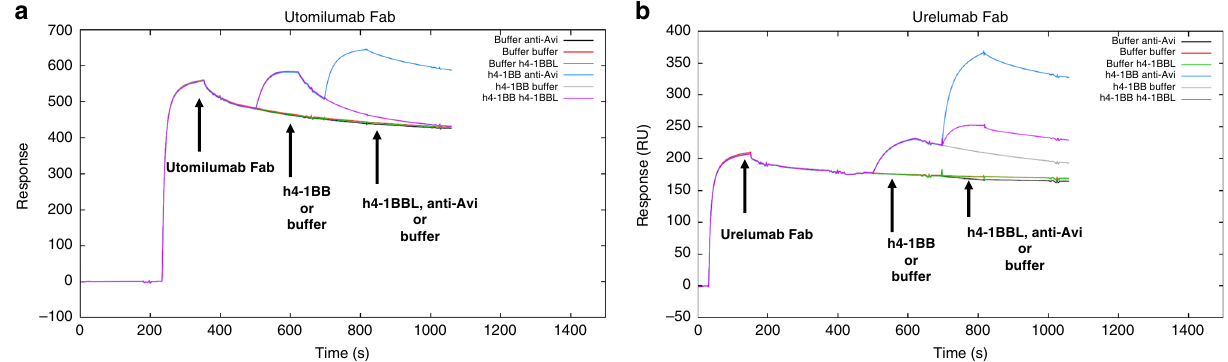
Fig. 5 Sandwich ligand-blocking assay by SPR. Full sensorgrams for a utomilumab Fab was captured onto anti-human lambda surface or b urelumab Fab was captured onto anti-human kappa surface to determine blocking of the interaction of h4-1BB receptor with h4-1BBL. The legend shows the fi rst analyte sample name followed by the second analyte. Triplicate measurements are consistent with one another; therefore, sensorgrams from third replicates are shown. Utomilumab Fab blocks the h4-1BB receptor/h4-1BBL interaction while urelumab Fab does not. Anti-Avi tag antibody was used to demonstrate binding to h4-1BB receptor by its Avi-tag when receptor is bound to utomilumab Fab or